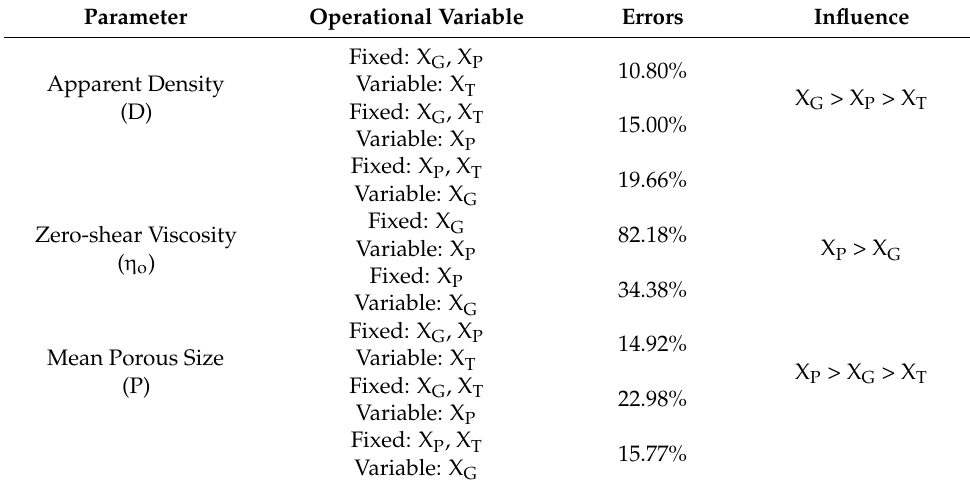
Table 5. Summary of the estimation of the influence of operational variables in the processing parameters of Ti sponges.